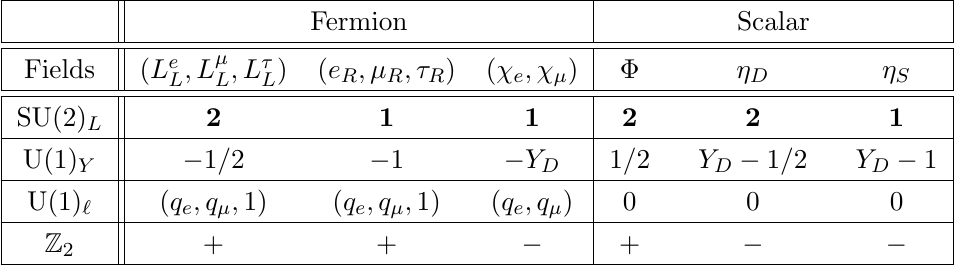
Z L (cid:10) U(1) Y (cid:10) U(1) ‘ (cid:10) 2 , = q (cid:22) . The parameter 6